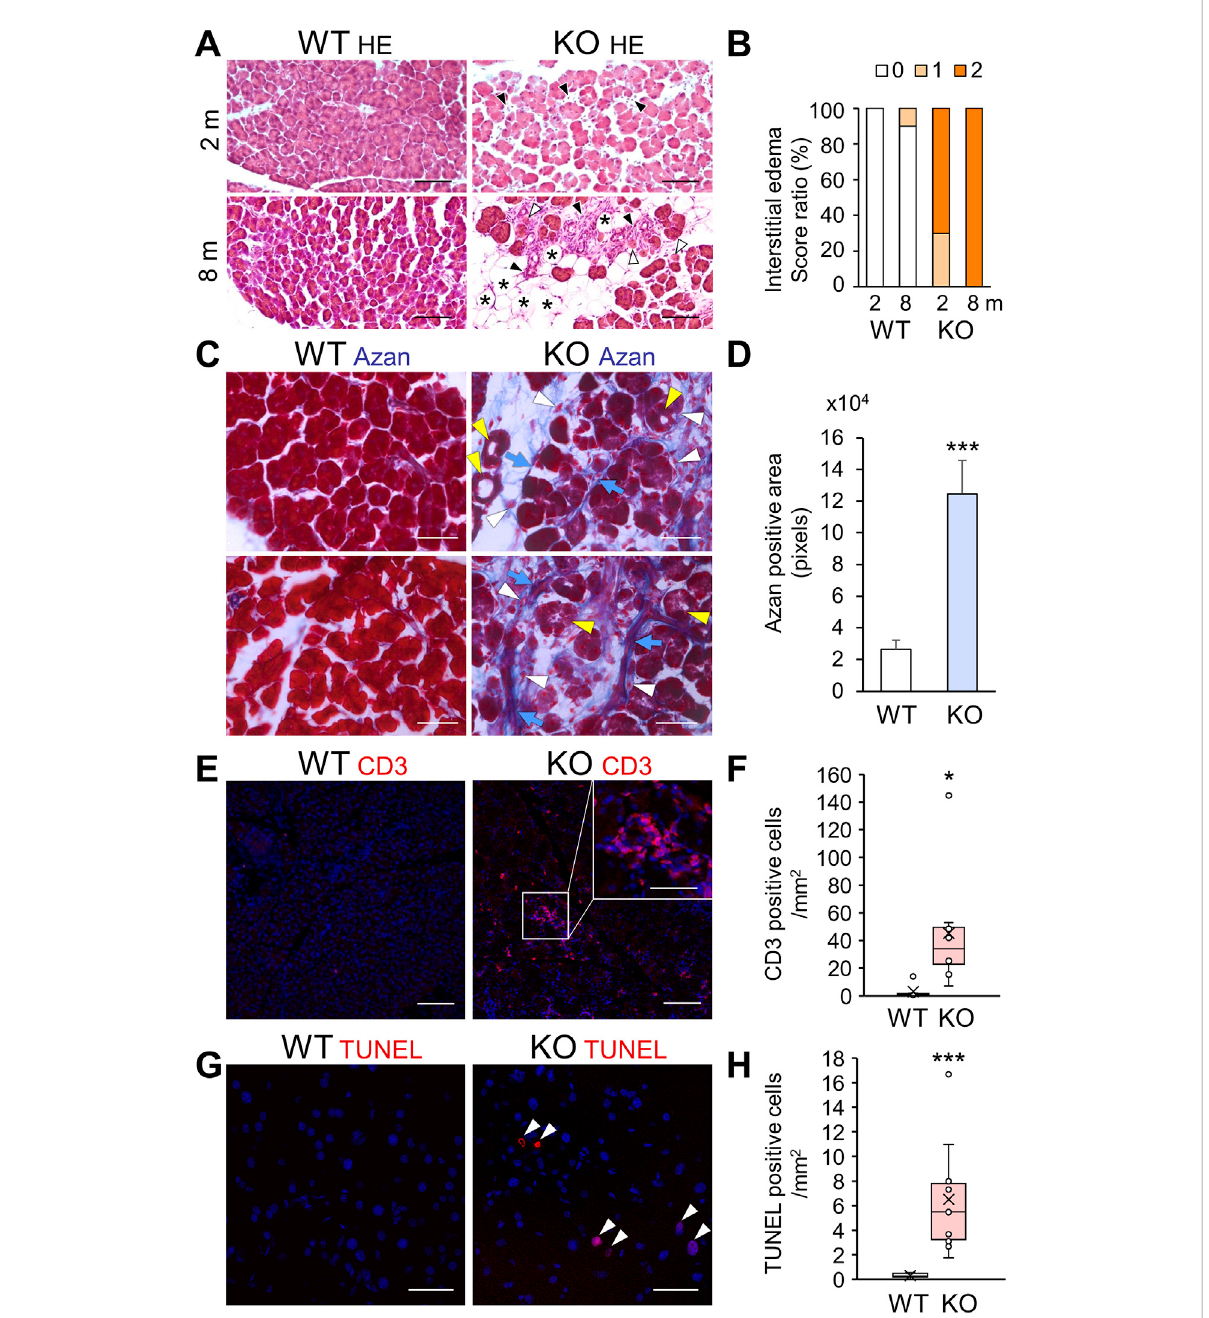
FIGURE 5 Acinar cell pathology with increased fi brosis, immune in fi ltration, and apoptosis in the exocrine pancreas of Cadps2 -KO mice. (A) , HE-stained pancreaticsectionsofKOmiceat2 months(2 m,toprow)and8 months(8 m,bottomrow)ofage.Degenerationofacinar cells( whitearrowheads ), increase in adipocytes replacing acini ( asterisks ), and interstitial in fi ltration between acini ( black arrowheads ) of the exocrine pancreas are indicated. Scale bars: 100 μ m. (B) , Score ratio (%) of interstitial edemas in the exocrine pancreas of WT and KO mice at 2 and 8 months (m) of age. The parameter was evaluated on a scale from 0 to 2 (0: normal or not detectable, 1: mild ( < 10% of visual fi eld)] or focal accumulation, 2: moderate to severe ( < 10%) or diffusely scattered accumulation), as described previously (Barth et al., 2002; Geisz et al., 2019). Mice analyzed after 2 months, WT ( n = 7) and KO ( n = 10); after 8 months, WT ( n = 10) and KO ( n = 10). (C) , Azan (blue)-stained fi brotic collagen components in pancreatic sections of WT and KO mice at 2 months of age. Blue arrows , white arrowheads, and yellow arrowheads indicate fi brosis collagen, interstitial in fi ltration such as pancreatic stellate cells and/or in fl ammatory cells, and atrophic-like acinar cells, respectively. Scale bars: 100 μ m. (D) , Azan-positive fi brosis areas (pixels). Ten ROI sections (100 × 220 μ m) randomly selected for each pancreas sample of WT and KO mice at 2 months of age were analyzed [WT ( n = 3) 26,338.9 ± 5,855.8 and KO ( n = 7) 124,616.1 ± 21,124.3]. Values represent the mean ± SEM. Student ’ s t -test: *** p = 0.0022. (E) , CD3 ( red )